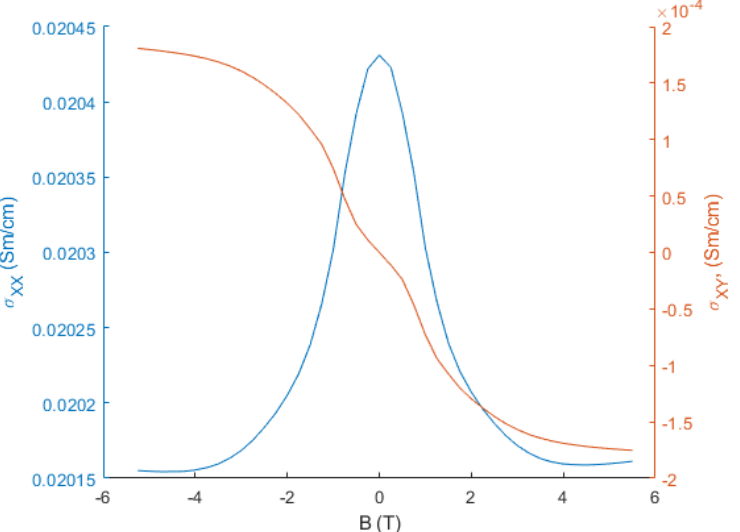
Figure 5. Longitudinal and Hall conductivities as a function of the magnetic field at 1.8